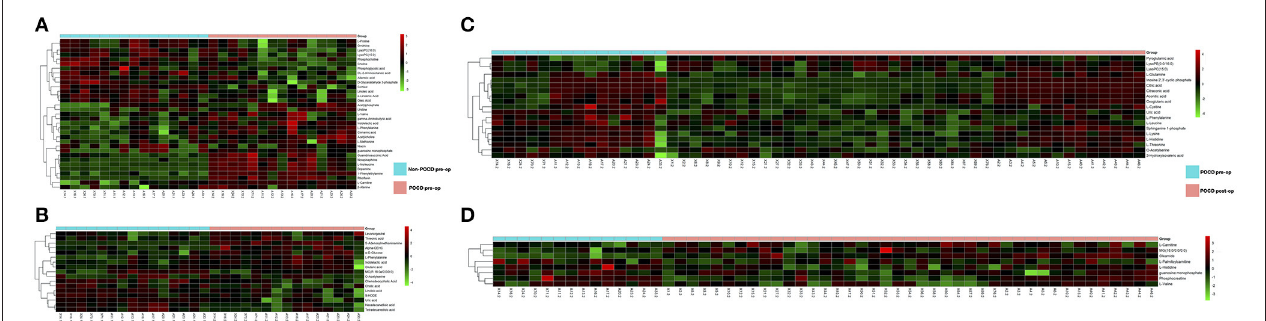
FIGURE 4 | (C,D) Metabolic patterns in before and after surgery POCD groups. Differentiating blood metabolites between before and after surgery POCD groups were shown as heatmaps. (A,B) Metabolic patterns in POCD and Non-POCD groups. Differentiating blood metabolites between POCD and Non-POCD groups were shown as heatmaps. Each row represented data for a specific metabolite, and each column represented an individual. Different colors corresponded to the different intensity levels of metabolites. Red and green colors represented increased and decreased levels of metabolites,